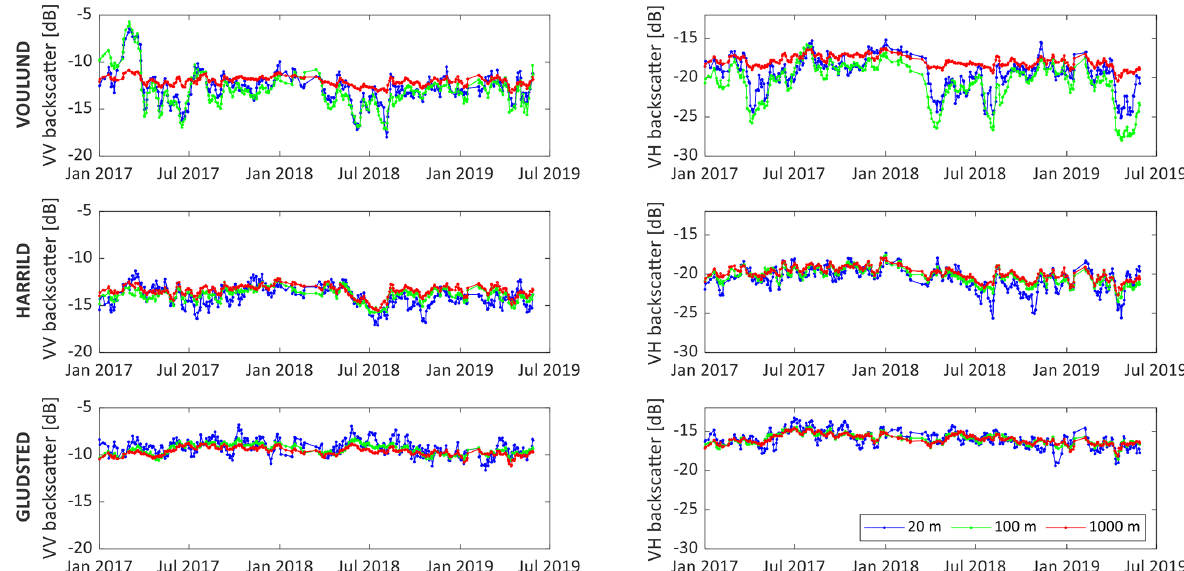
Figure 8. Time series of Sentinel-1 VV and VH backscatter at different aggregation levels (20, 100 and 1000m) at the three CRNS sites at Voulund (agriculture), Harrild (heathland) and Gludsted (forest).